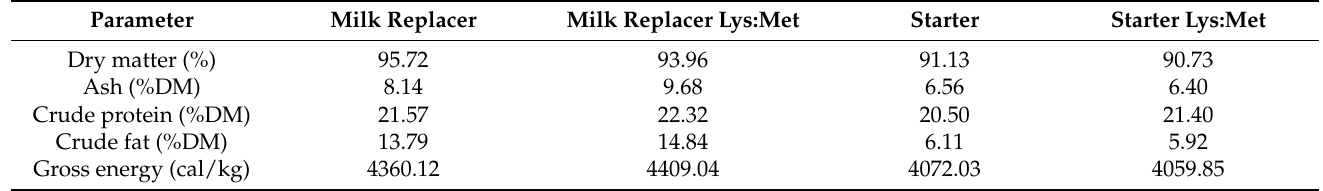
Table 1. Chemical composition of milk replacer and starter, with or without lysine and methionine supplementation.